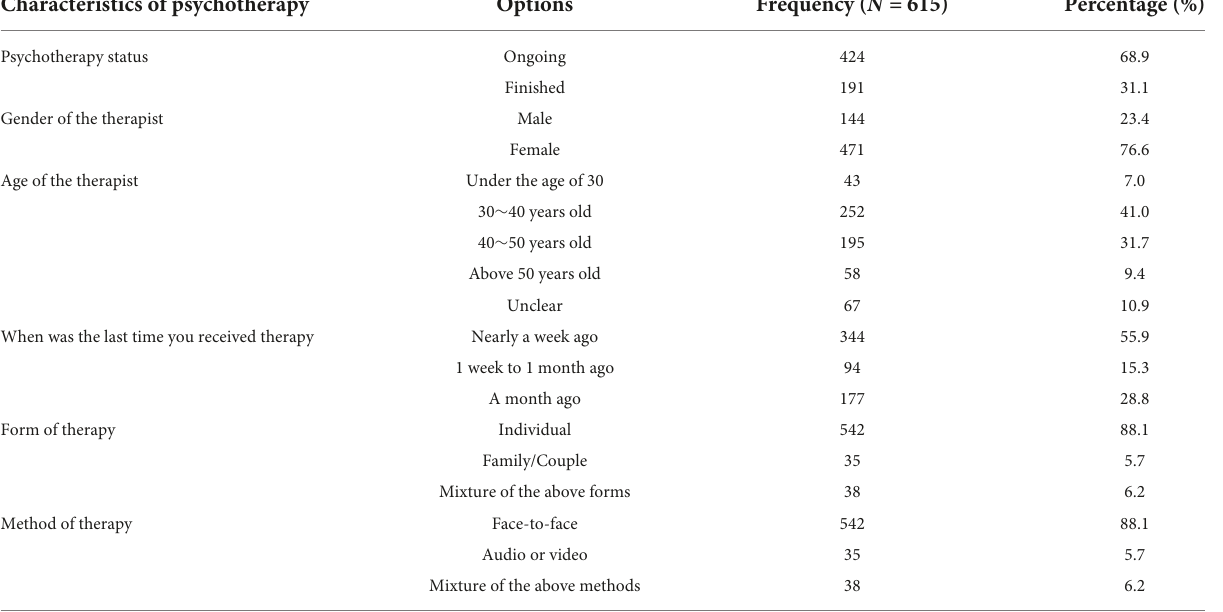
TABLE 3 Background information of participants’ participation in psychotherapy in sample 2. Characteristics of psychotherapy